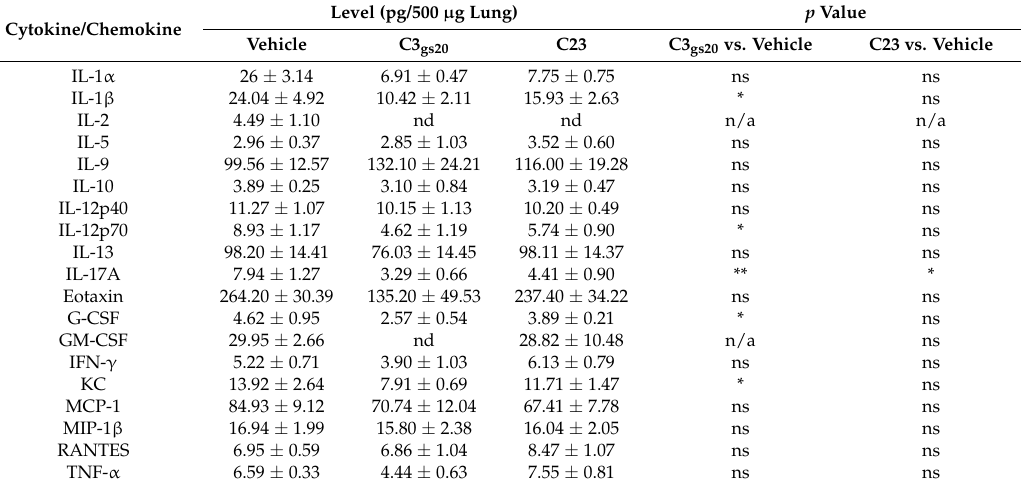
Data are expressed as mean ± SEM. Statistical significance is indicated: * p < 0.05, ** p < 0.01. ns: not significant; nd: not detectable; n/a: not applicable. GM-CSF, granulocyte-macrophage colony-stimulating factor; KC, keratinocyte chemoattractant, TNF- α , tumor necrosis factor alpha.